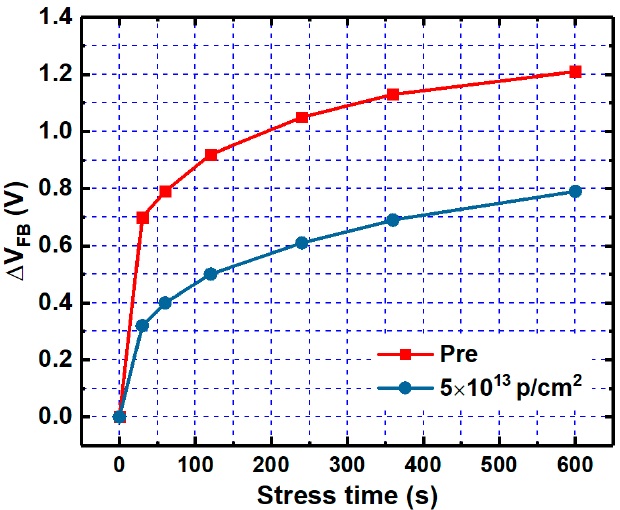
Figure 22. HF C-V characteristics of the samples irradiated by the dose of 5 × 10 13 p / cm 2 with the stress time. Nanomaterials 2020 , 10 , x FOR PEER REVIEW 15 of 17